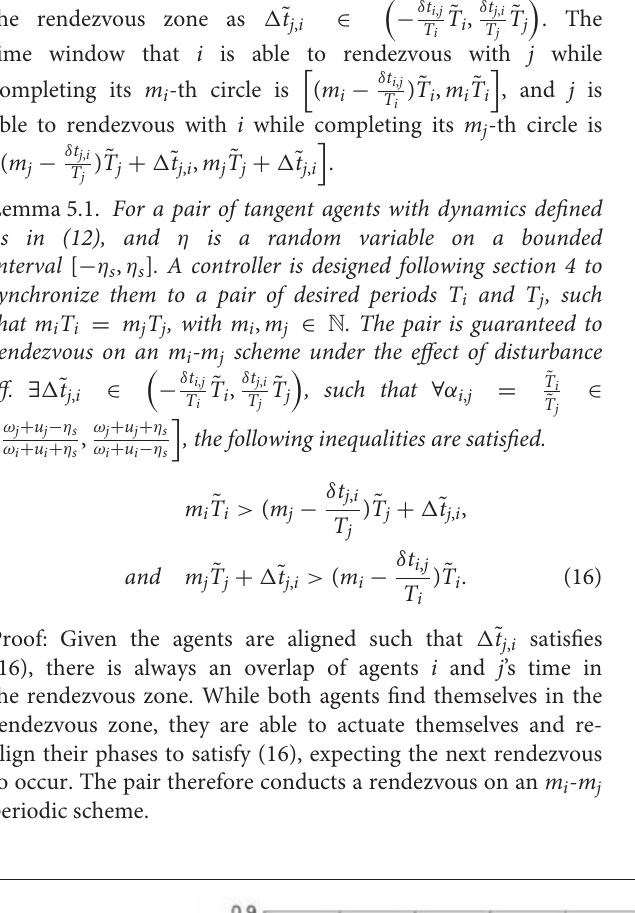
Frontiers in Robotics and AI |